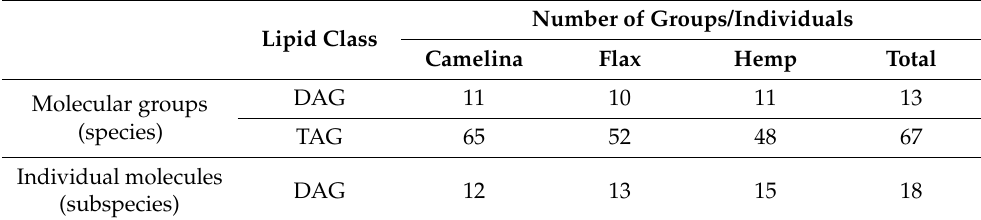
Table 1. Number of molecular lipid groups and individual lipid